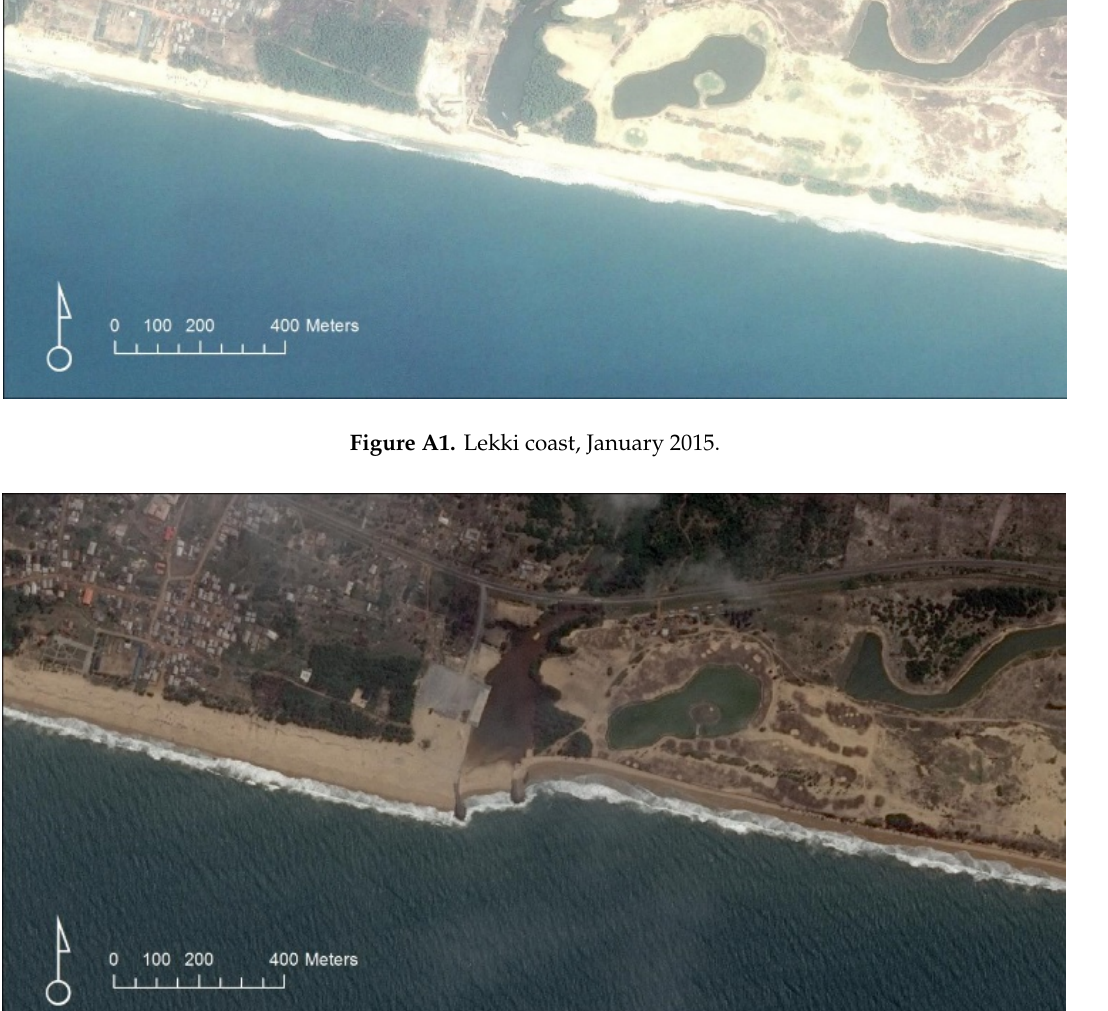
Figure A2. Lekki coast, May 2016.